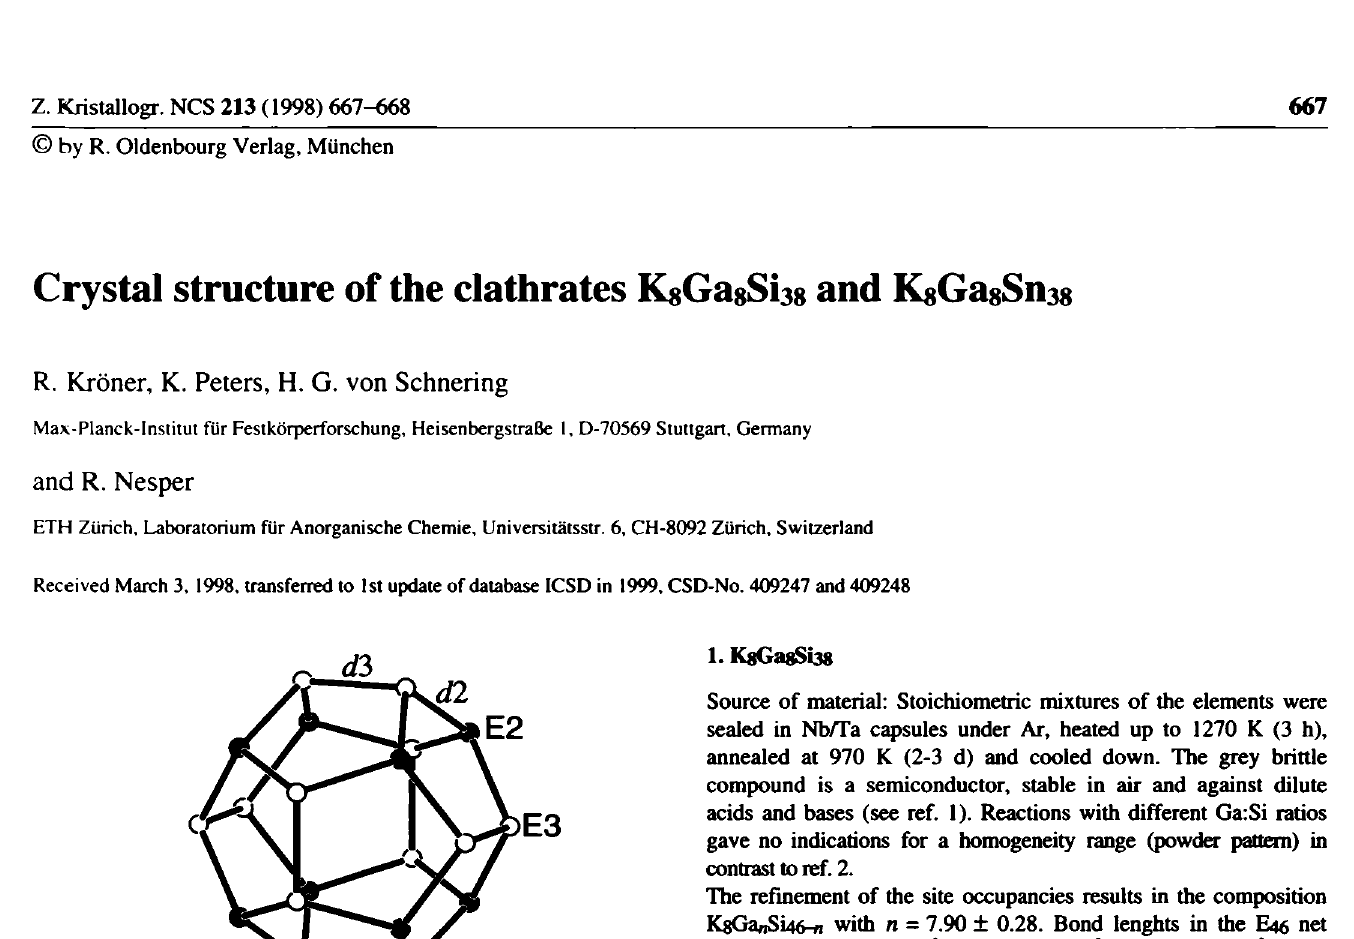
Table 2. Final atomic coordinates and displacement parameters (in A^)